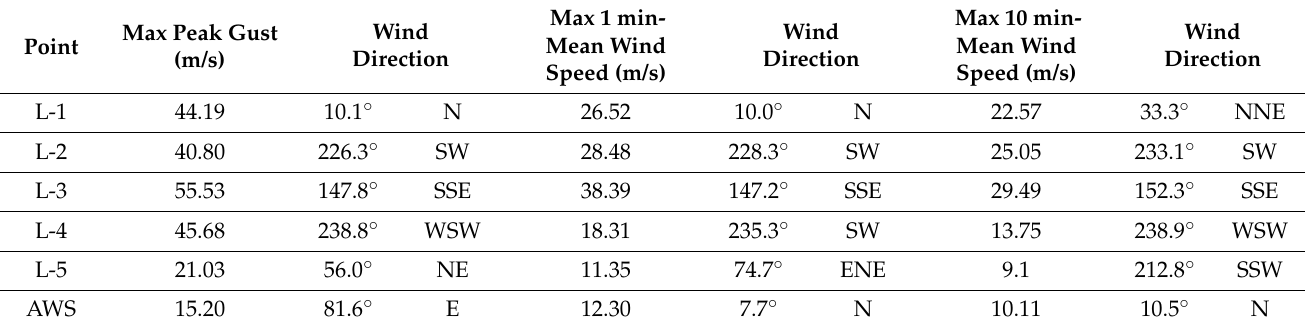
Figure 9. Windrose at each point ( a – e ) L-1 to L-5, respectively. Table 2. The mean wind speeds and peak gusts at each point (L-1 to L-5 and